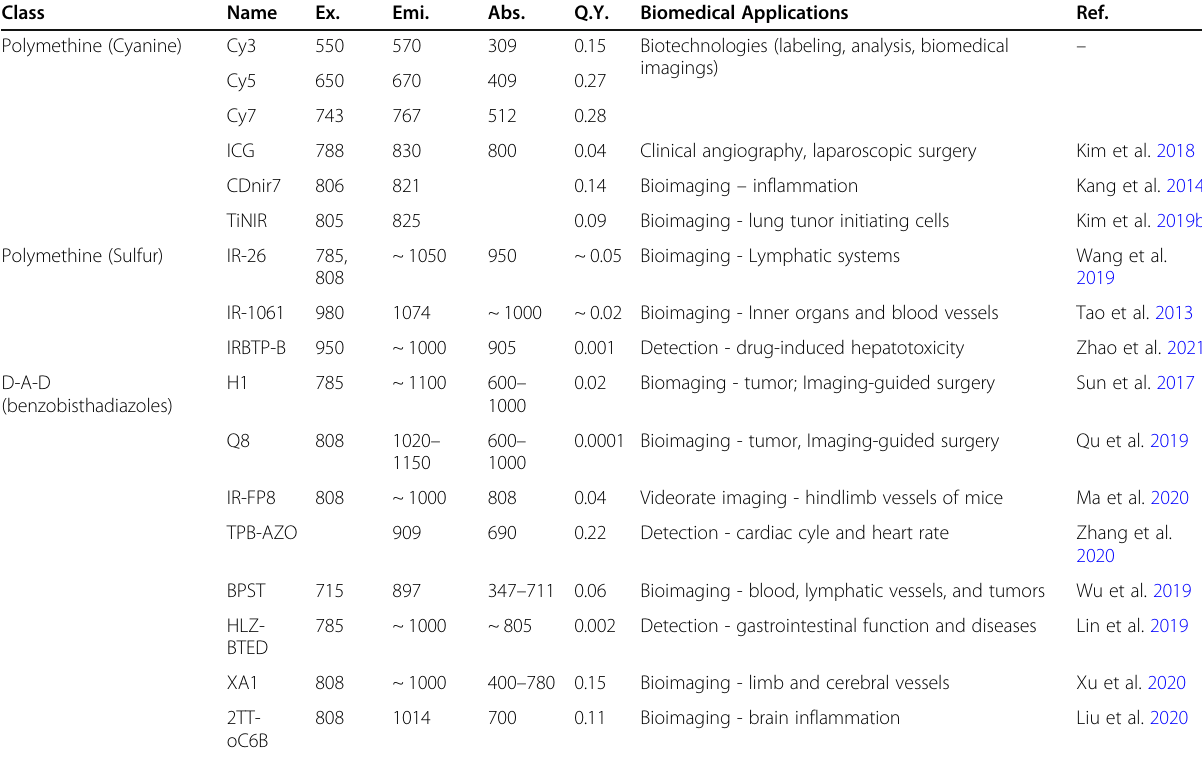
Table 1 Summary of the NIR organic dyes